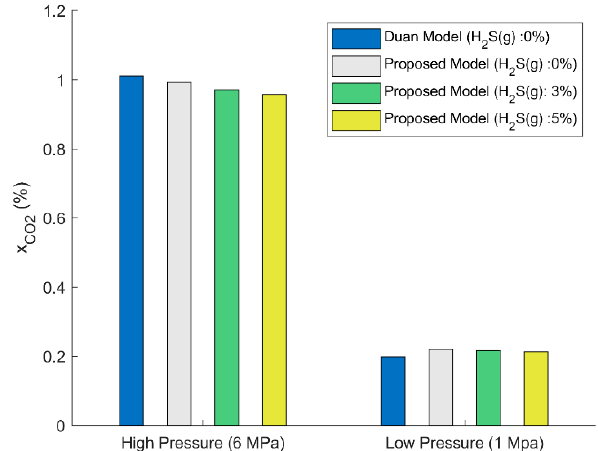
Figure 10. Geothermal case study: effect of H 2 S on the solubility of CO 2 (Temperature: 89 °C).